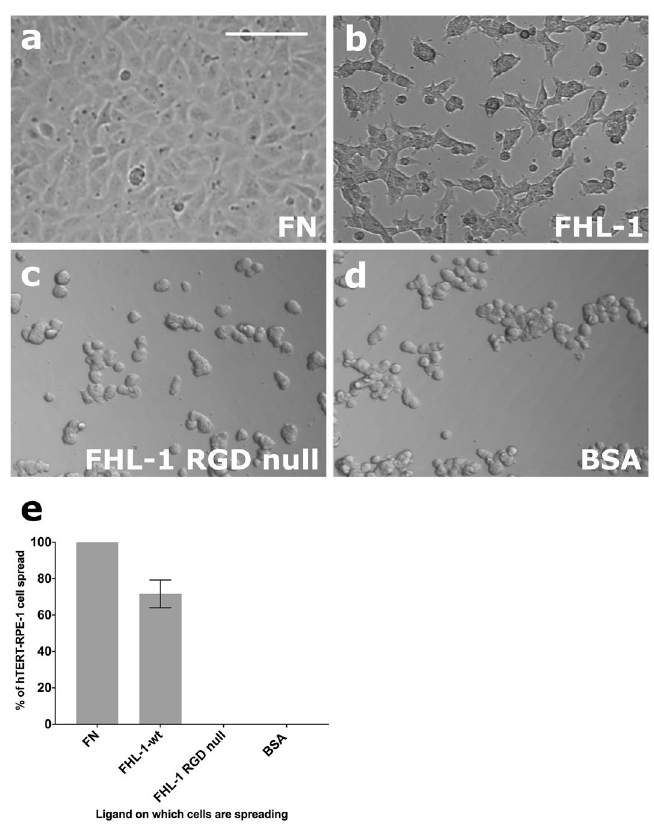
Figure 5. hTERT RPE-1 cells mirror the FHL-1 binding of primary RPE cells. The hTERT RPE-1 cell line was tested for FHL-1 binding by addition to different matrices at the same density (10,000 cells in each well of a 96-well plate), including ( a ) FN; ( b ) FHL-1; ( c ) FHL-1 RGD null; and ( d ) BSA. ( e ) the number of spread cells were counted in four different visual fields for each condition and each condition were measured in triplicate. The percentage of spread cells was calculated and compared to the positive control, FN. Data are the mean results of three independent experiments and each performed in triplicate. Images in ( a - d ) are representative of 3 independent experiments. Incubation was done for 3 h at 37 °C. Data in ( e ) represent n = 3 ± s.e.m. Scale bar represents 100